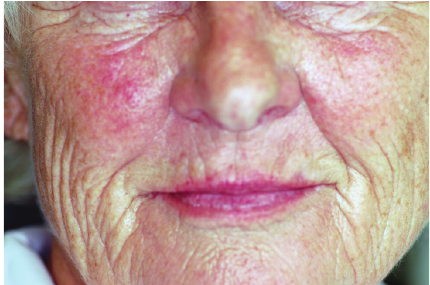
Figure 1: Clinical findings: discreet swelling and reddening infraor- bital on the right side, only visible in comparison to the contralateral side.